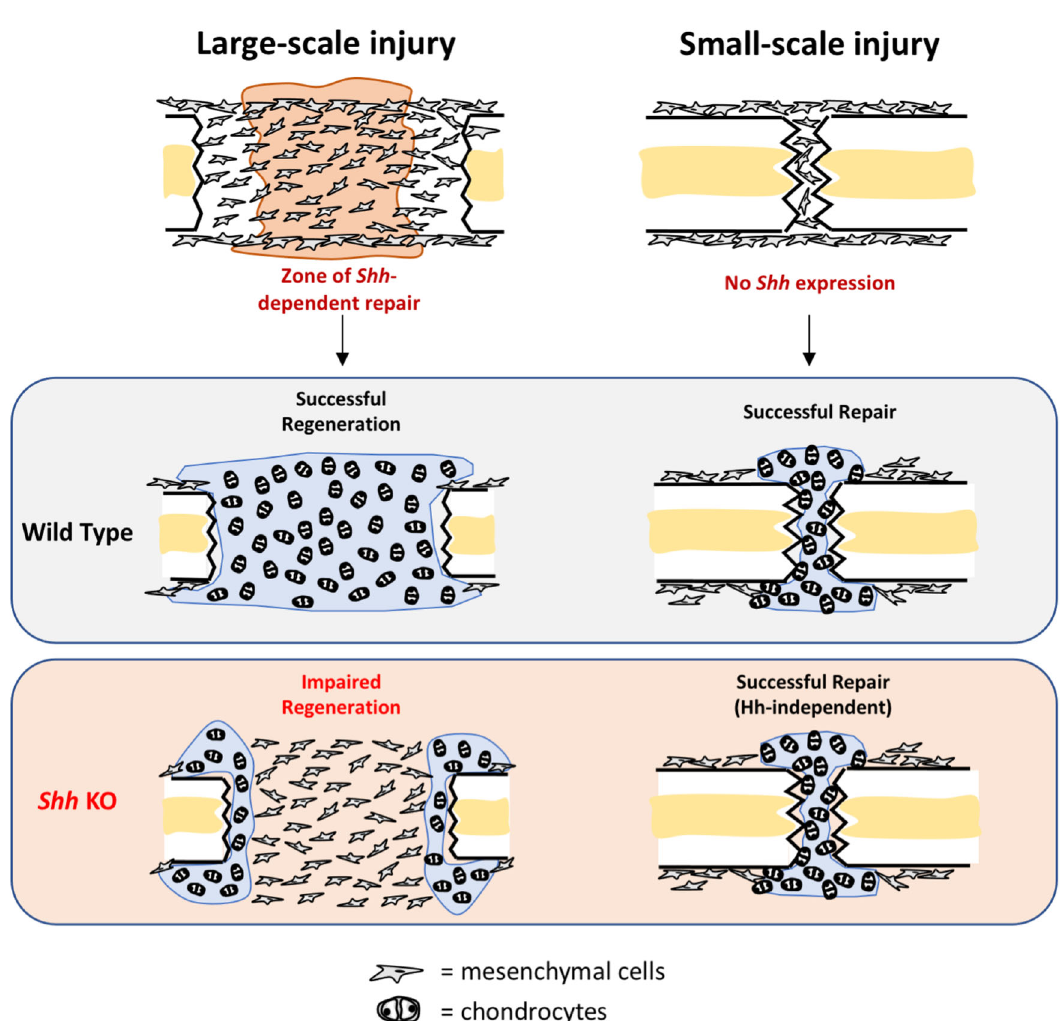
Fig. 10 Summary model. In response to large-scale injury in the rib, Shh is rapidly and broadly upregulated in Prrx1 -expressing mesenchymal cells that can be found in the central injury region at 3 – 5 days post injury (dpi), whereas Shh expression is not detectable in response to small- scale injury. In animals where Shh is conditionally removed ( Shh KO), large-scale injuries do not generate cartilage in the central callus area and subsequently do not heal successfully. In contrast, the full repair of small-scale injuries (both in rib and femur) largely does not require Hh signaling. Thus, bone repair is a process that can involve region-speci fi c signaling requirements depending on the injury type and Shh is selectively required to build a centrally located bridging callus during large-scale